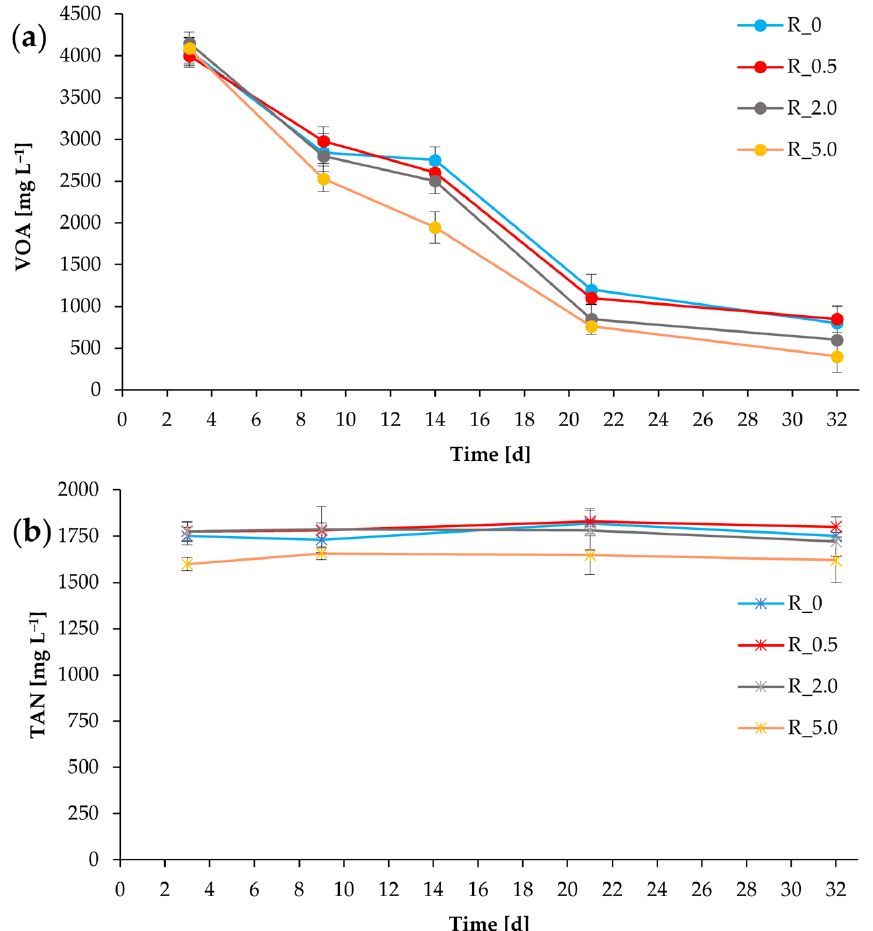
Figure 2. Impact of CNT addition on VOA concentrations ( a ) and TAN concentrations ( b ) during the anaerobic digestion of chicken manure. Different concentrations of CNTs (0.5 g L − 1 , 2.0 g L − 1 , and 5.0 g L − 1 ) were added to the reactors (R_0.5, R_2.0, and R_5.0, respectively). R_0 operated without